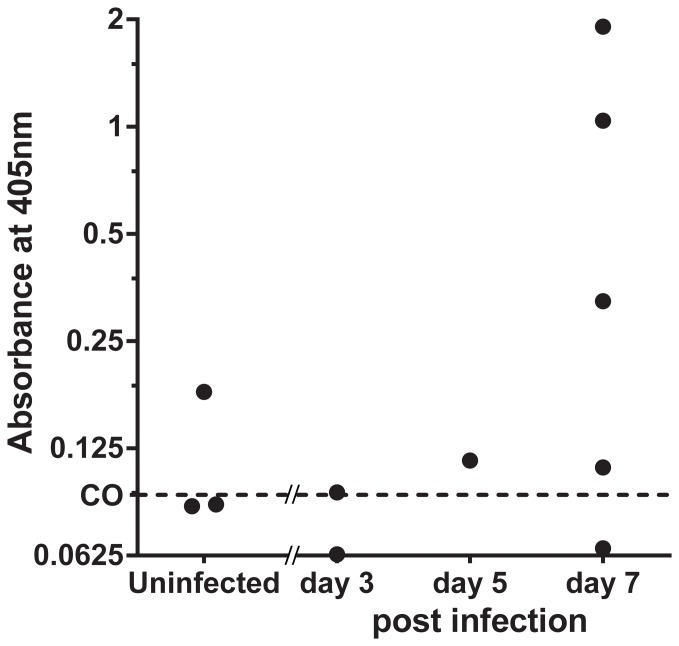
MAb476 detects a urinary excreted Galf antigen in a GP model of pulmonary IA.Processed (10-fold concentration/7 KDa-desalting) urines samples were tested in sELISA; 6 out of 8 infected guinea pigs had detectable antigenuria. Cut off (CO) value equals the mean+3SD of the absorbances of negative controls.